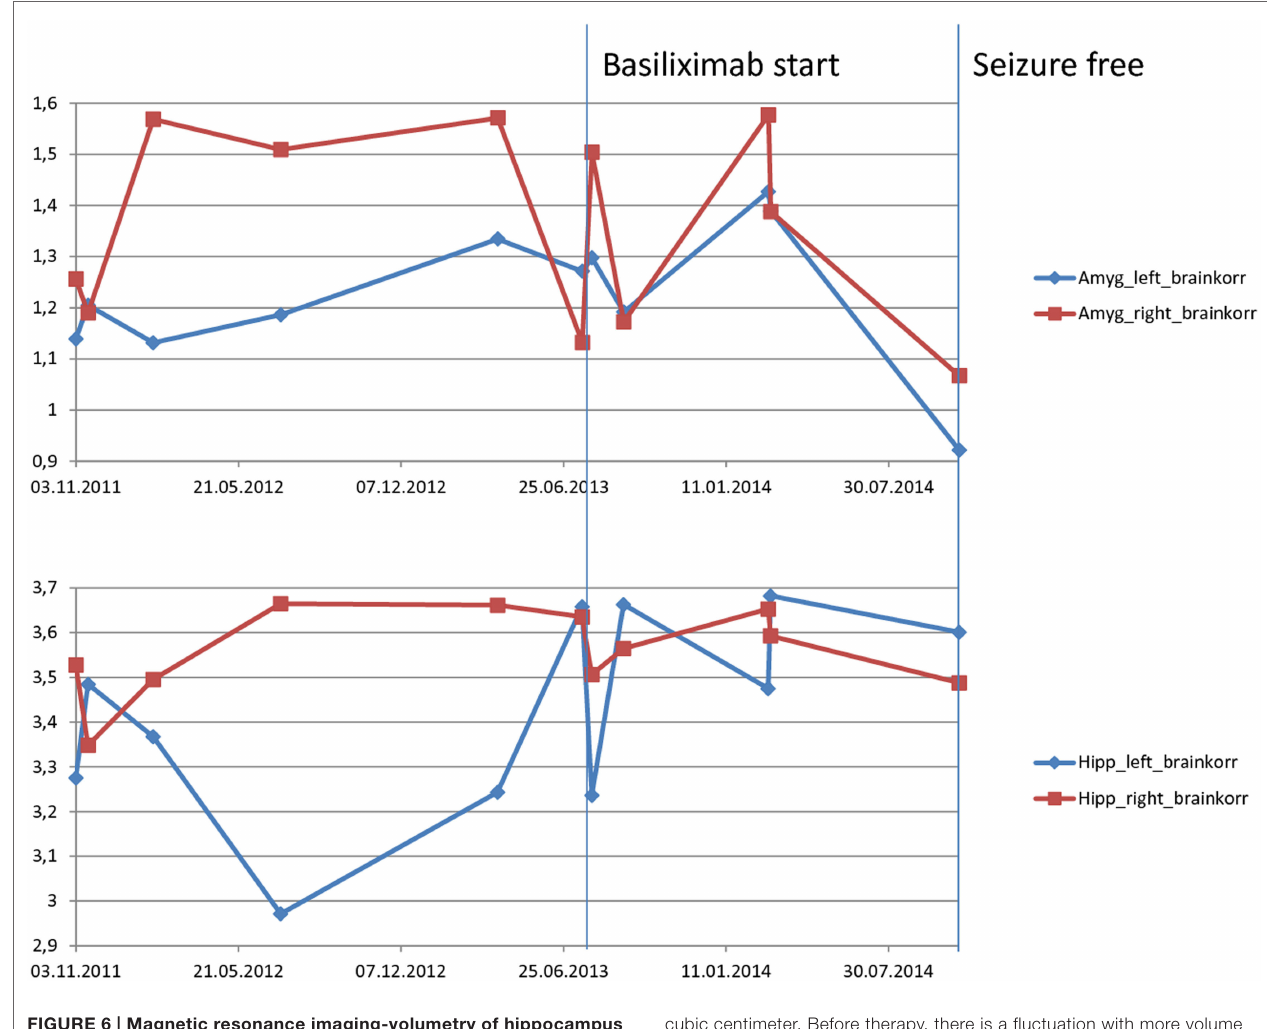
FiGuRe 6 | Magnetic resonance imaging-volumetry of hippocampus and amygdala (measured in cubic millimeter) corrected by the whole brain volume (measured in cubic centimeter) of each scan . The resulting values are unitless values measured as cubic millimeter per